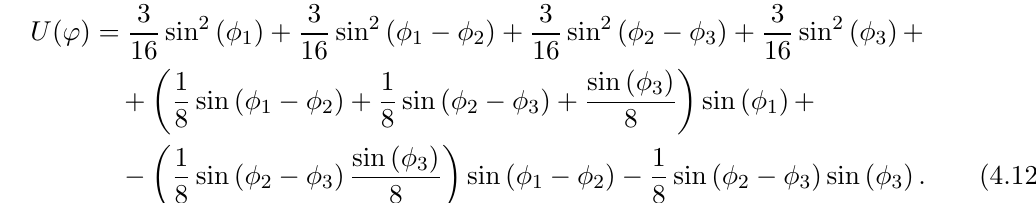
= 1, i = 1 ; 2 ; 3, adopted from now on, i